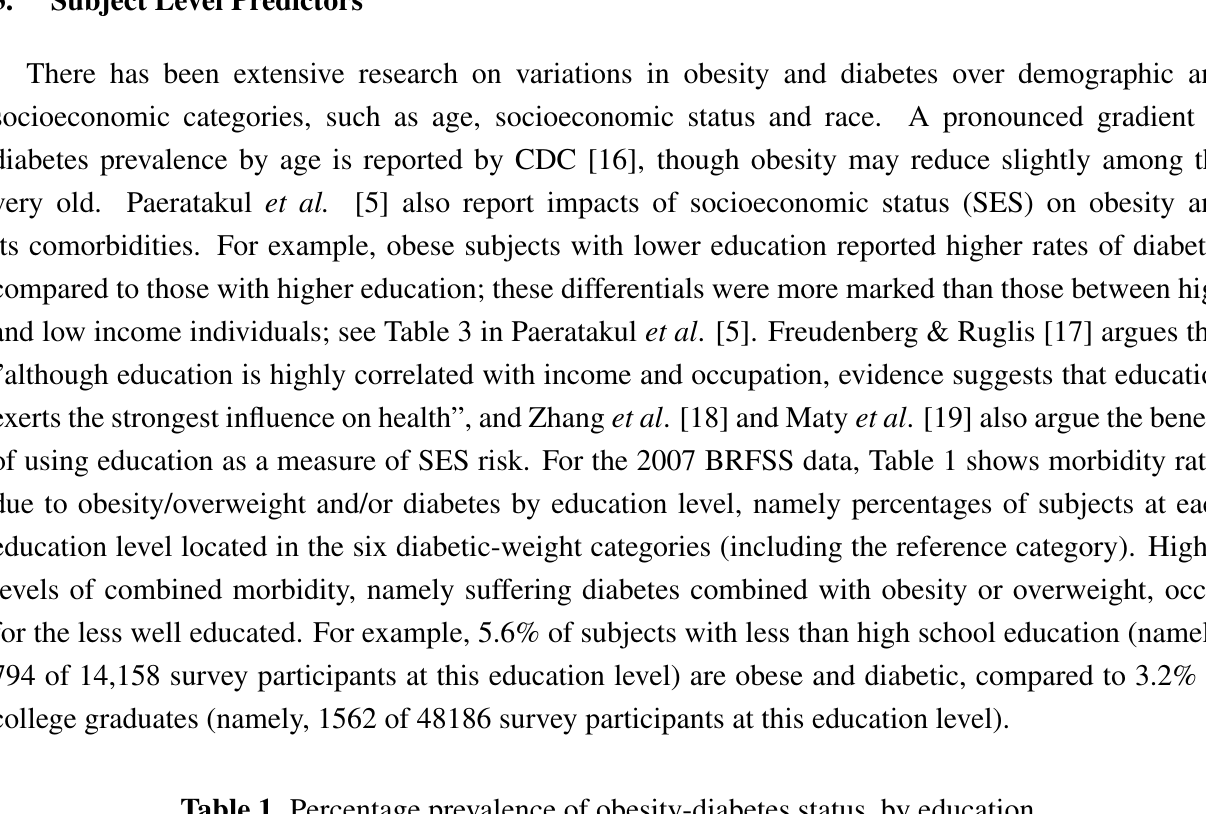
Table 1 . Percentage prevalence of obesity-diabetes status, by